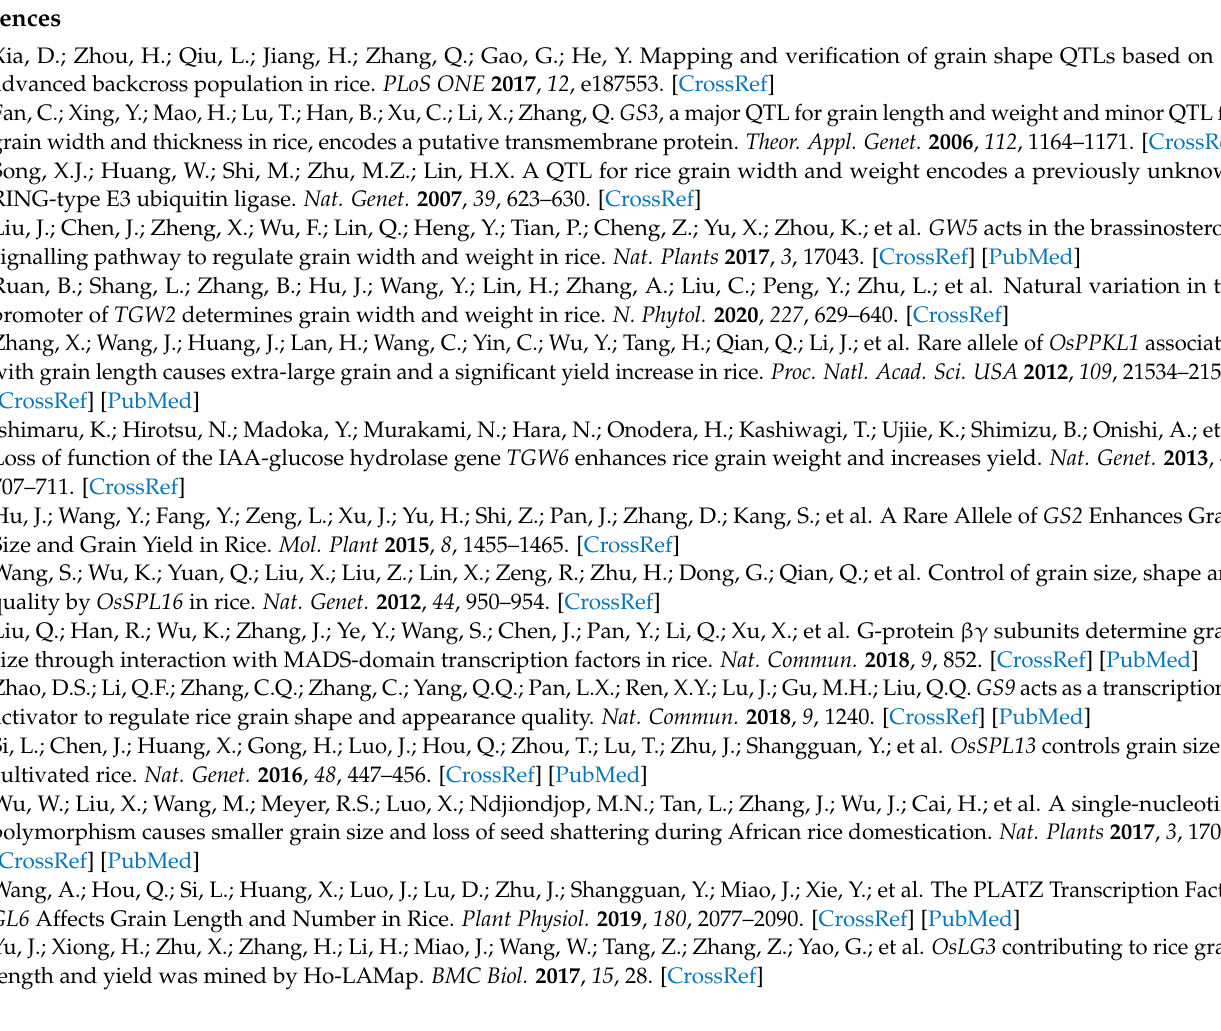
Table S1: Means of grain shape related traits for the parental lines and RISL population. Table S2: QTLs for grain shape identified in the RISL population in one environment. Table S3: Detection and annotation of SNPs and